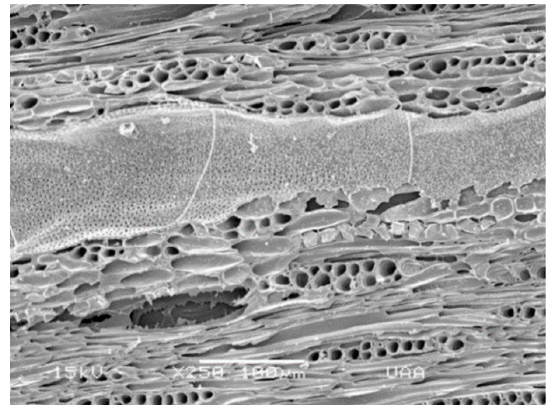
Figure 2. Structure of biochar (BC) 1 from manchineel tree and pine (60/40) mixed wood produced with Kon-Tiki flame curtain kiln in Aguascalientes. Electron micrograph: 15 kV zoom × 250, Universidad Autónoma de Aguascalientes, November 2017.